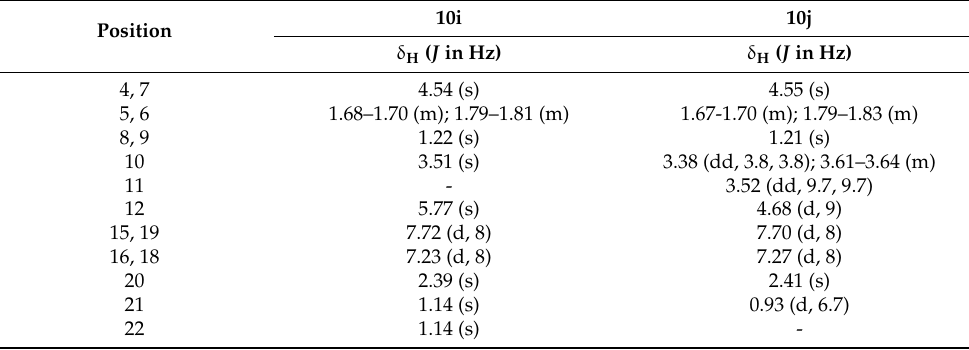
Table 1. 1 H chemical shifts ( ™ ) of sulfonamide-cantharidinimides 10i and 10j (CDCl 3 , 500